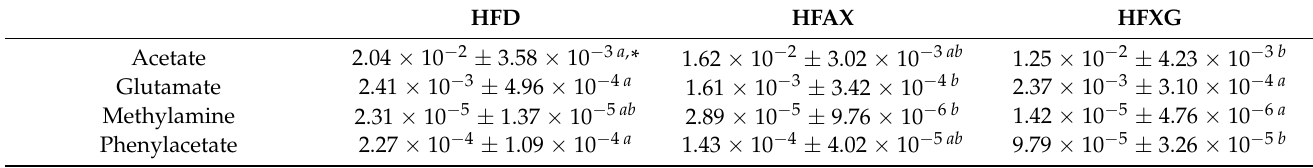
Table 2. Molecules with significant differences in cecum contents of HFD, HFAX, and HFAG groups.